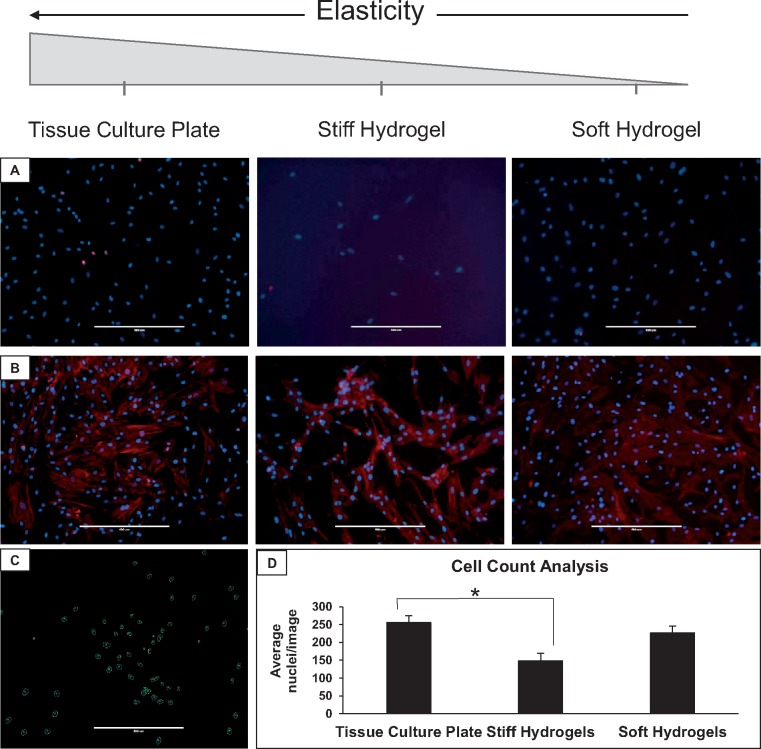
hMSCs attach to and survive on the different hydrogel compositions. (A) Viability assay of hMSCs cultured on tissue culture plates, stiff hydrogels and soft hydrogels for 72 hours. Live cell nuclei are shown in blue, while dead cell nuclei are shown in red. (B) Morphology of hMSCs cultured on the three elasticity conditions for 72 hours. The cell nuclei are shown in blue, while the F-actin filaments are shown in red. (C) Visual depiction of ImageJ analysis highlighting nuclei for count. (D) Cell count results from ImageJ quantification of cells seeded for 72 hours. *Tukey HSD resulting P < 0.05. n = 3. Scale bars: 400 µm